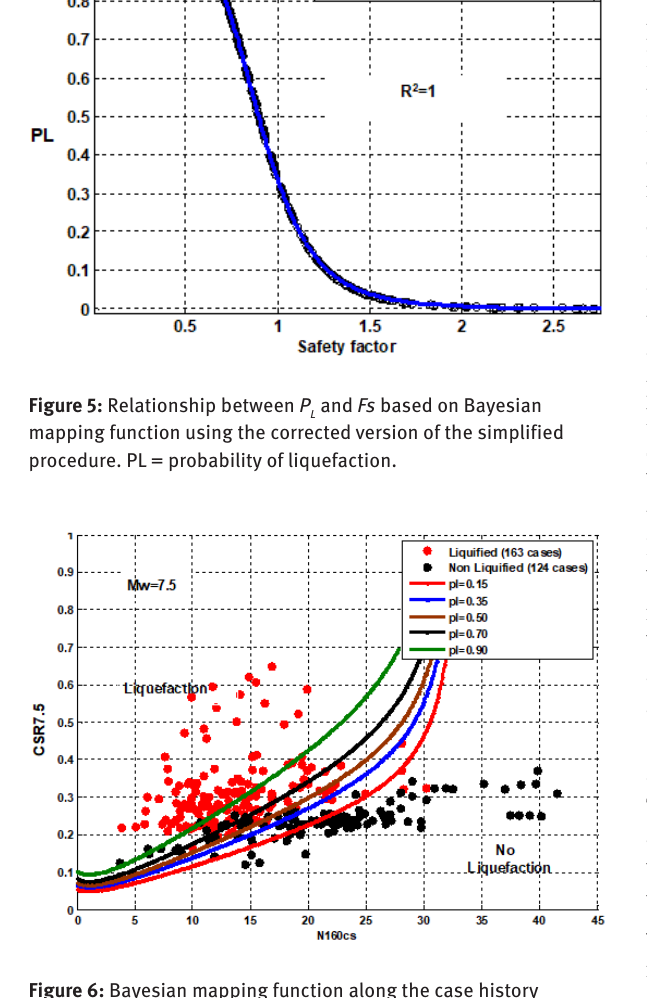
Figure 6: Bayesian mapping function along the case history databaseusing the corrected version of the simplified procedure with Eq.(17). CSR = cyclic stress